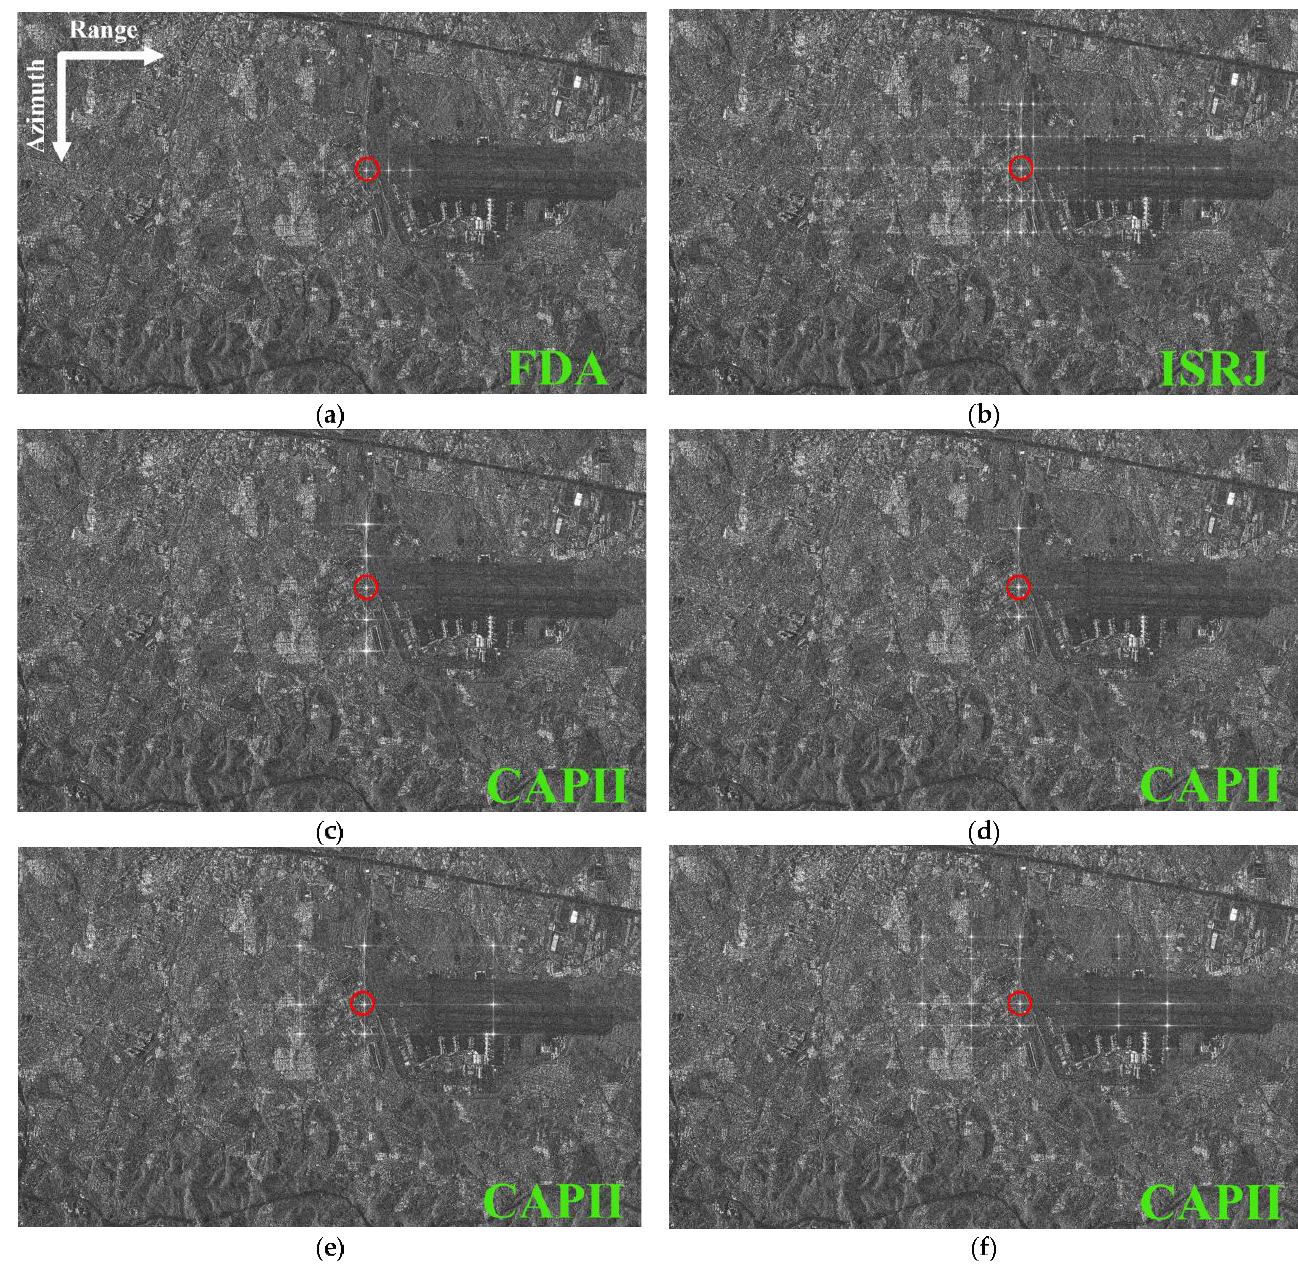
Figure 14. Area target simulation results (the real target is inside the red circle). ( a ) The results of the FDA-based jamming method. ( b ) The results of the ISRJ method. ( c ) The results of CAPII with M a = 3 (encoding value randomly). ( d ) The results of CAPII with M a = 3 (the amplitude encoding value of the second set is 0). ( e ) The results of CAPII with M a = M r = 3 (the second set of amplitude encoding values within inter-pulse is set to 0). ( f ) The results of CAPII with M a = M r = 4 (the third set of amplitude encoding values within the inter-pulse is set to 0).